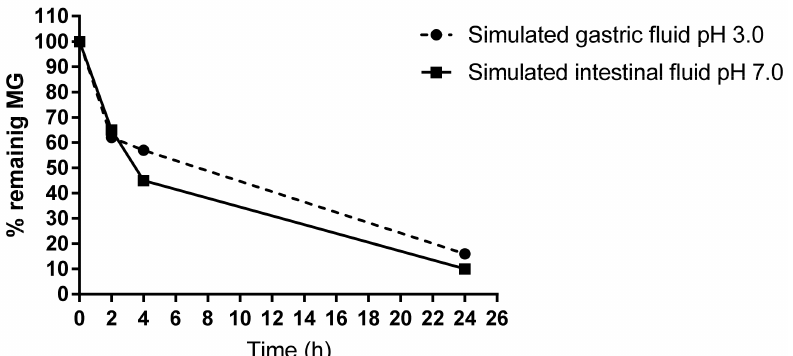
Figure 5. HPLC measurement of free MG remaining in the gastrointestinal digestion mix. The simulated gastric and intestinal fluids were analyzed after an incubation time of 0, 2, 4, and 24 h at 37 ◦ C. About 40% of free MG disappeared after 4